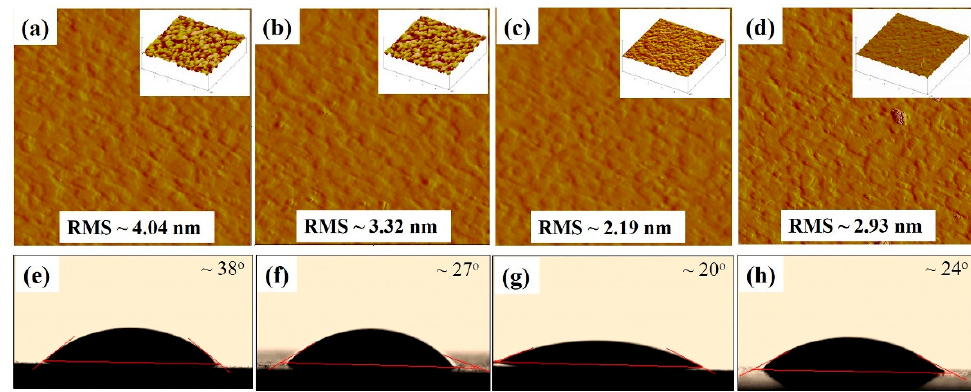
Figure 7. The AFM phase images of the ( a,b,c,d ) glass/ITO/WA-ZnONrod/(P3HT:PCBM)/WO 3 , (inset) AFM 3-Dimention images, and video contact angle images of the ( e,f,g,h ) glass/ITO/WA-ZnONrod/(P3HT:PCBM)/WO 3 dependent on the thickness and morphology of WO 3 buffer layer.